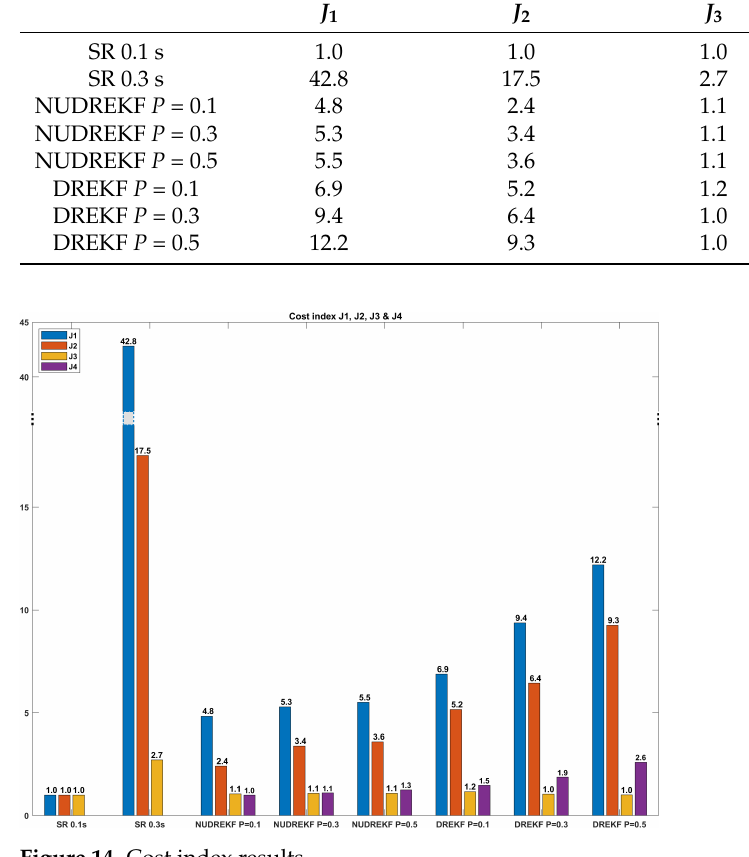
Figure 14. Cost index